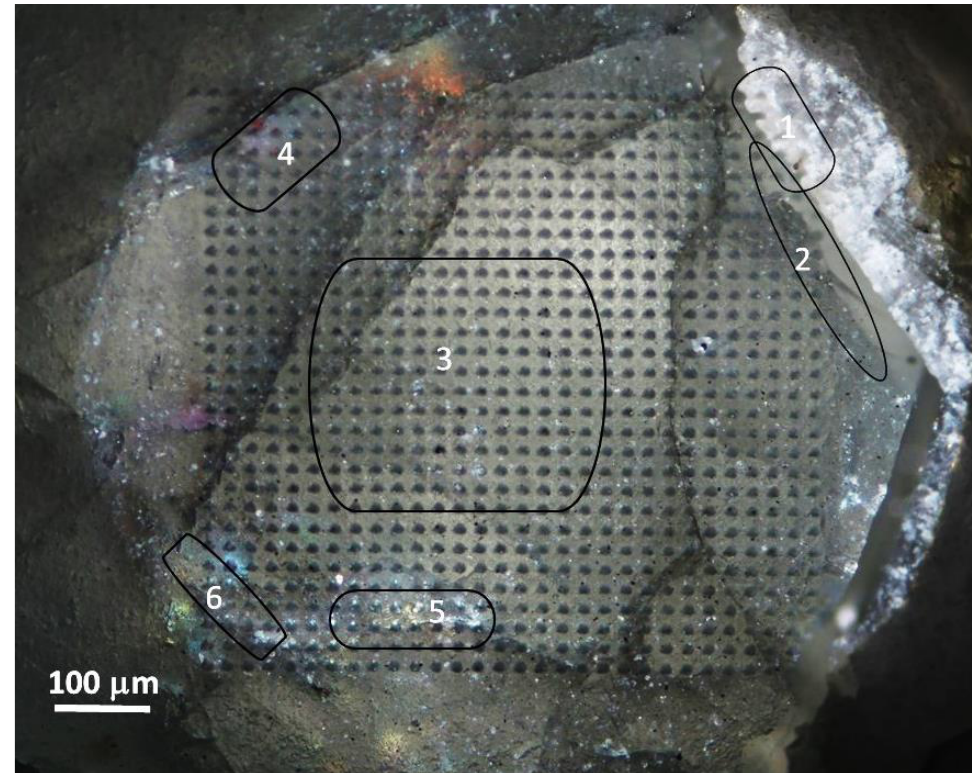
Figure 7. A microscope image of the apatite crystal surface along the z-axis with several crystalline sheets. On the left side the crystal is in contact with carbonatite rock (location 1) through a rim (location 2). The crystal core area (location 3) is surrounded by regions with enhanced abundances of (Th, U) at location 4, and Ba at locations 5 and 6.